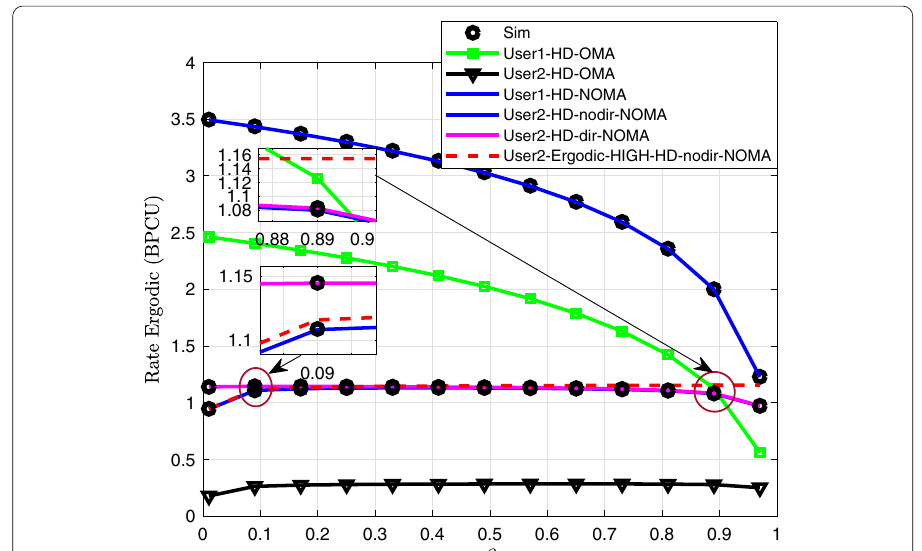
Fig. 6 The ergodic rate of two users versus β in cases of no direct link and direct link